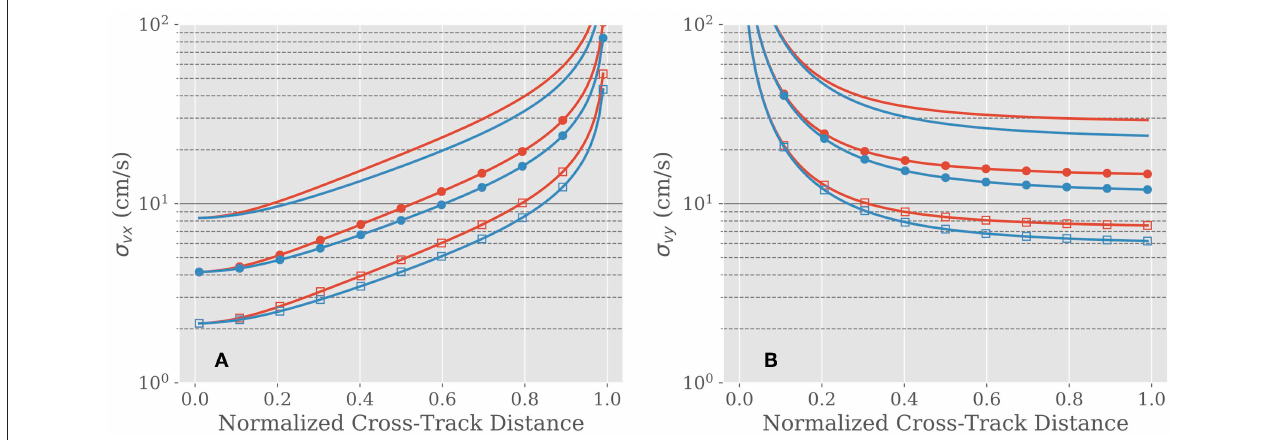
FIGURE 2 | Velocity component error as a function of the normalized cross-track distance from nadir in the (A) along-track ( σ vx ) direction (roughly North) and (B) across-track ( σ vy ) direction (roughly East),for antenna lengths of 4m (read), and 5m (blue). The peak output power is 100Watts (solid line), 400Watts (circles), and 1.5kWatts (squares). From Rodriguez